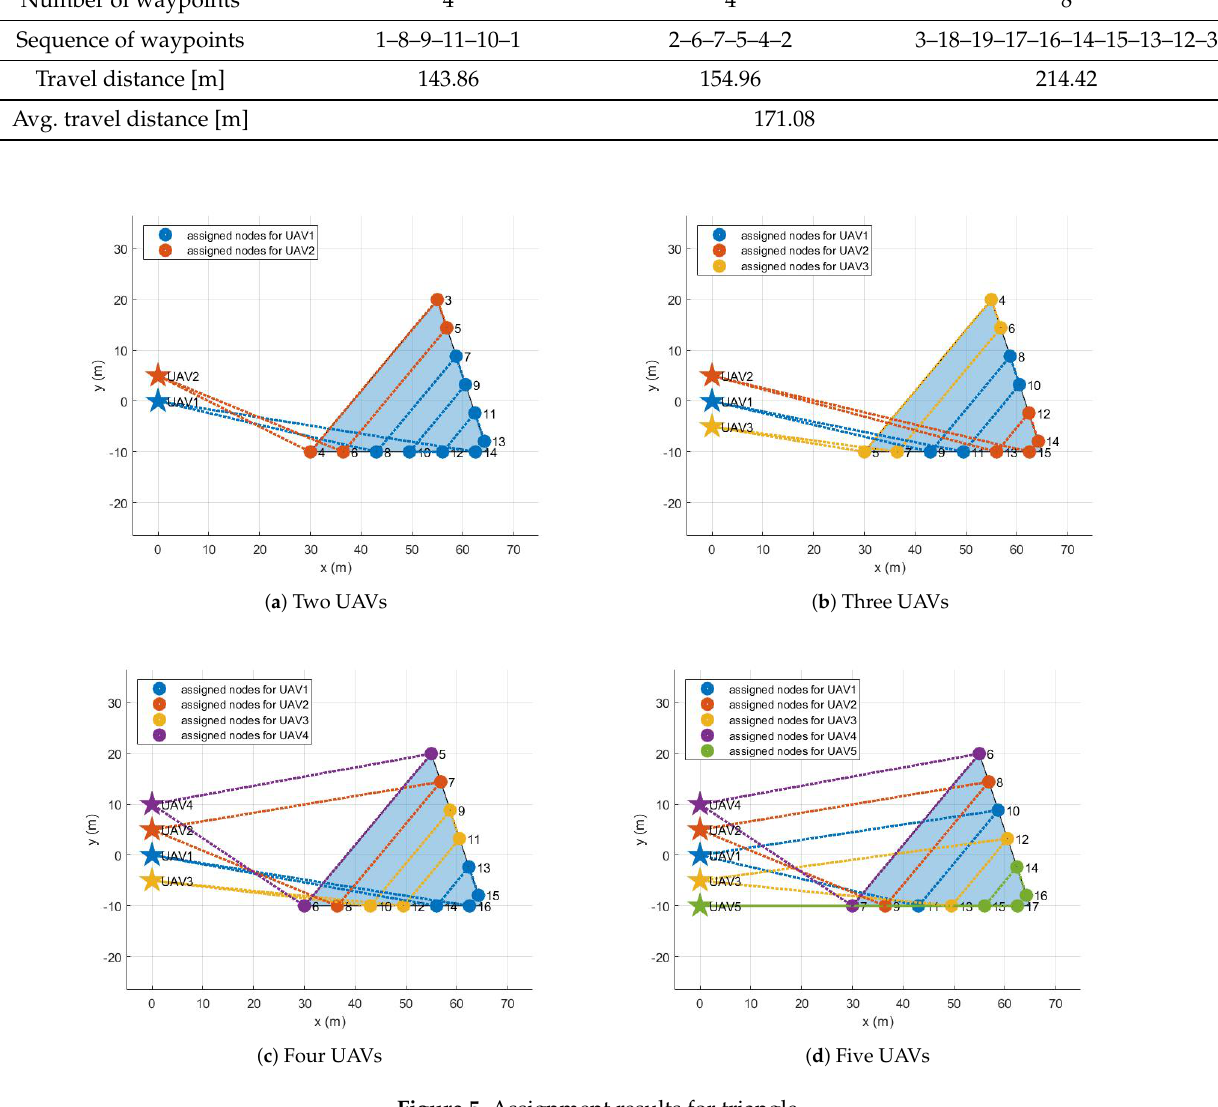
Figure 5. Assignment results for